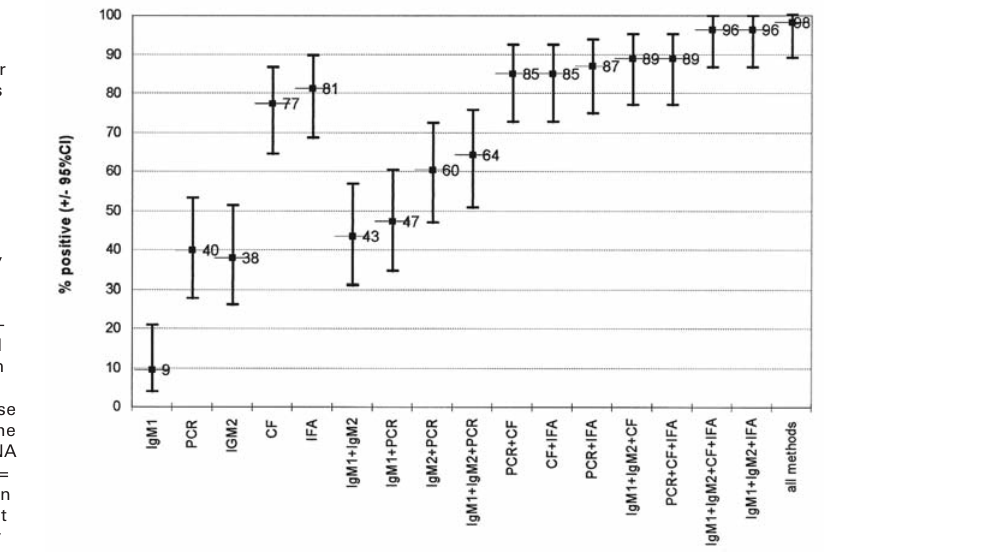
Figure 2 Comparison of the performance of four diagnostic methods and their combina- tions in acute and convalescent sera of 53 patients with herpes zoster. IgM1 and IgM2 = enzyme linked im- munosorbent assay (EIA) for varicella- zoster virus (VZV) IgM antibody detec- tion from acute and convalescent serum respectively; PCR = real-time polymerase chain reaction for the presence of VZV